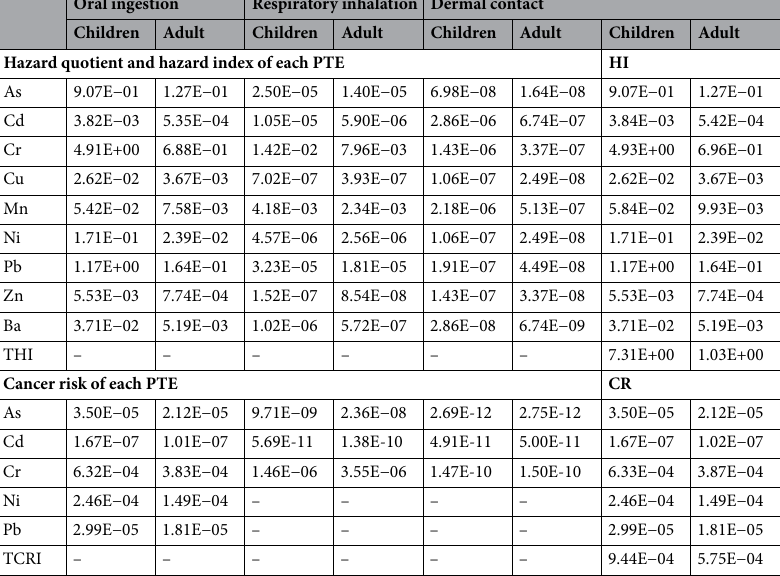
Table 3. Non-cancer and cancer risk assessment of adults and children under different exposure